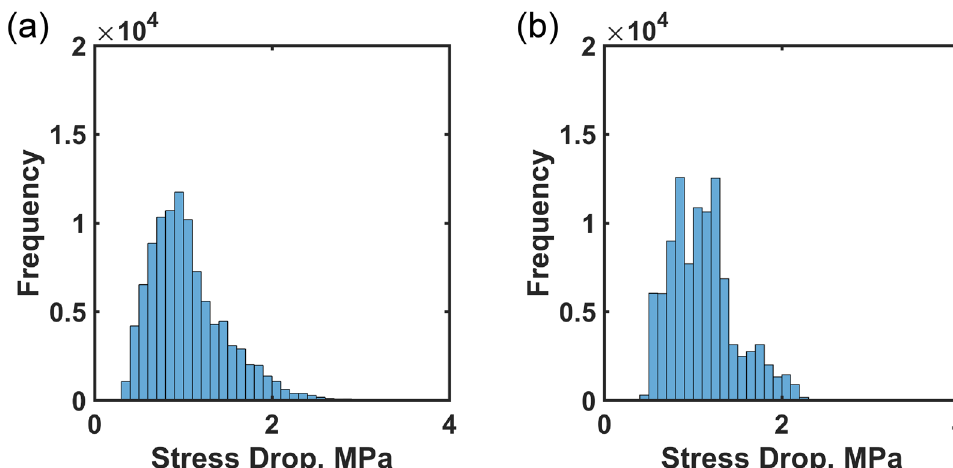
Fig. 3 Histogram of stress drop estimates of a large earthquake with synthetic data a assuming an F -distribution and b normal